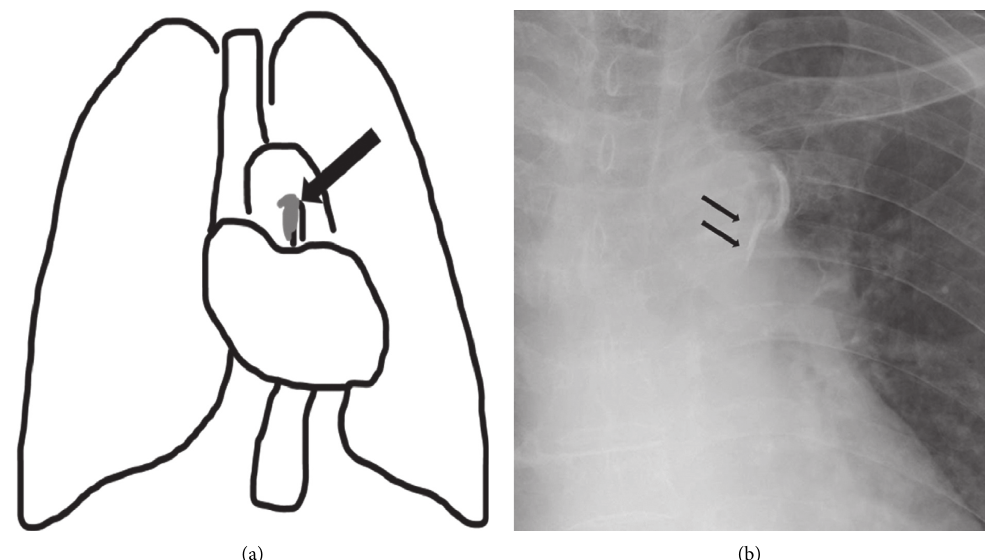
Figure 1: The scheme and representative X-ray images showing the Aortic Arch Tail Sign. The arrows show the calcification line of the ascending aorta adjacent to the aortic